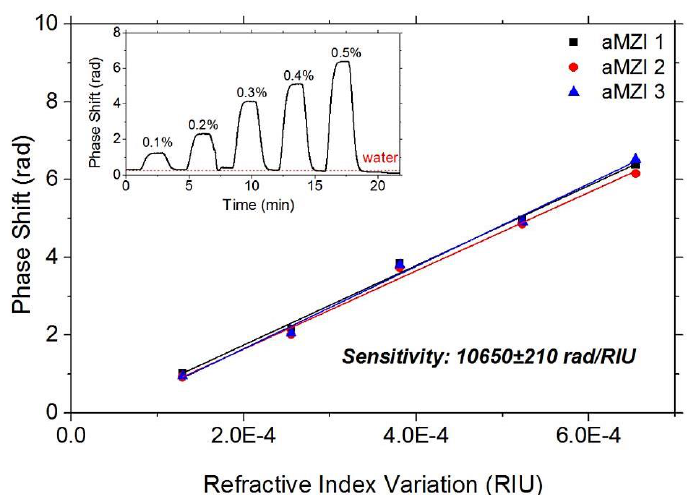
Figure 3. Volume sensitivity measurements. Evaluation of the bulk sensitivity; ( inset ) phase shift curve for one of the aMZI sensors during the injection of the water-glucose solutions (glucose concentration in %w/w labelled on the plot).